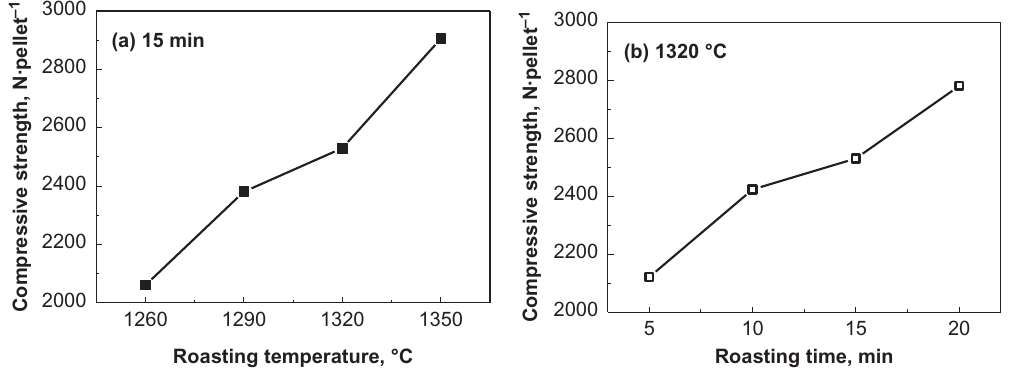
Figure 6: Effects of roasting time and temperature on compressive strength of roasted pellets.